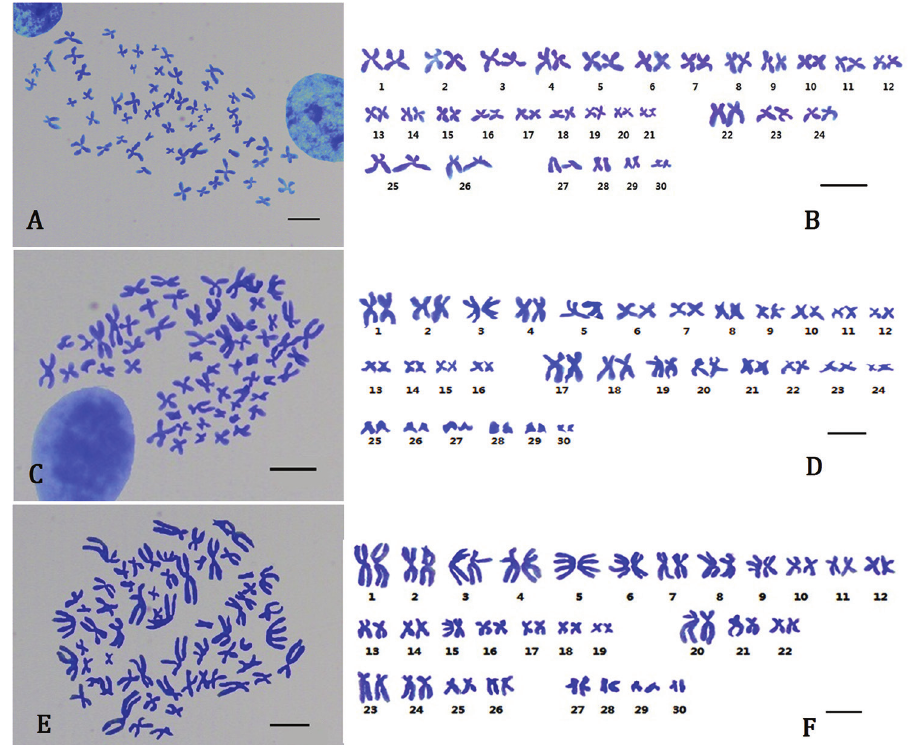
Figure 1. Photomicrographs of somatic diploid metaphase plates and karyotypes from three species of octopod gills. A The metaphase plate of O. minor B Karyogram of O. minor from ( A ) showing the